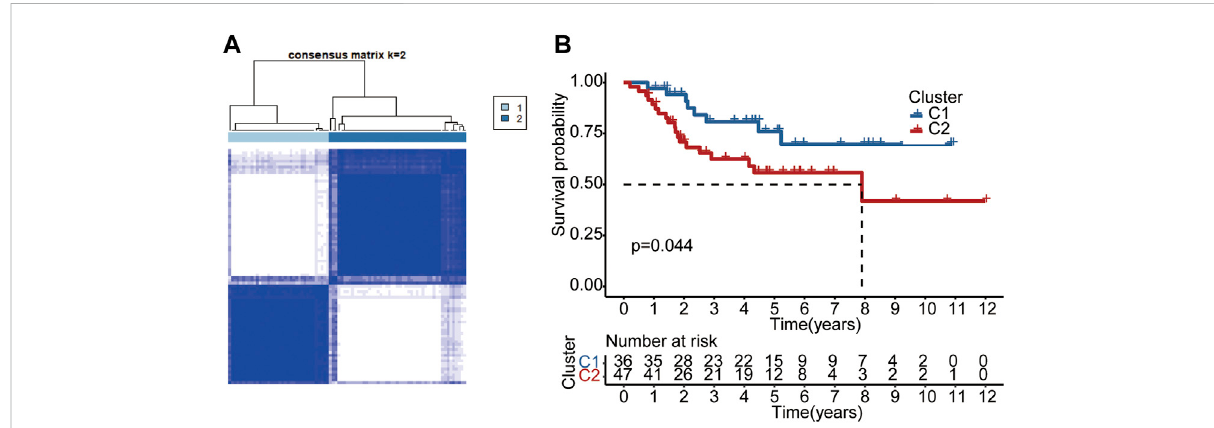
FIGURE 9 Subtypes ofOS according to DEGs. (A) Based on theconsensus clustering matrix, OS patients weredivided into two clusters (k =2). (B) Kaplan- Meier analysis of the two